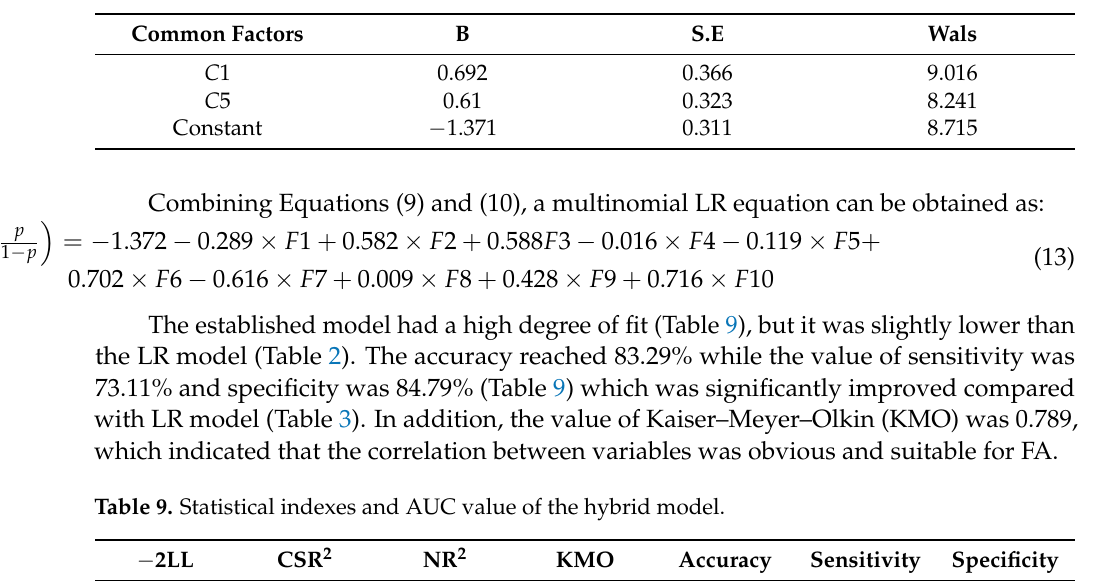
Table 8. The regression coefficients of common factors in LR model.